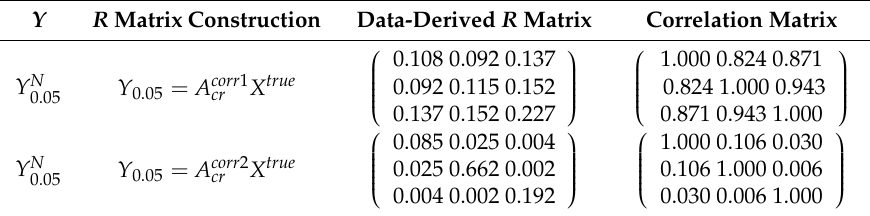
Table 5. Results for Case D, where Y N or Y d indicate data from N measured radiances, and the second d column means the R matrix was based on what for